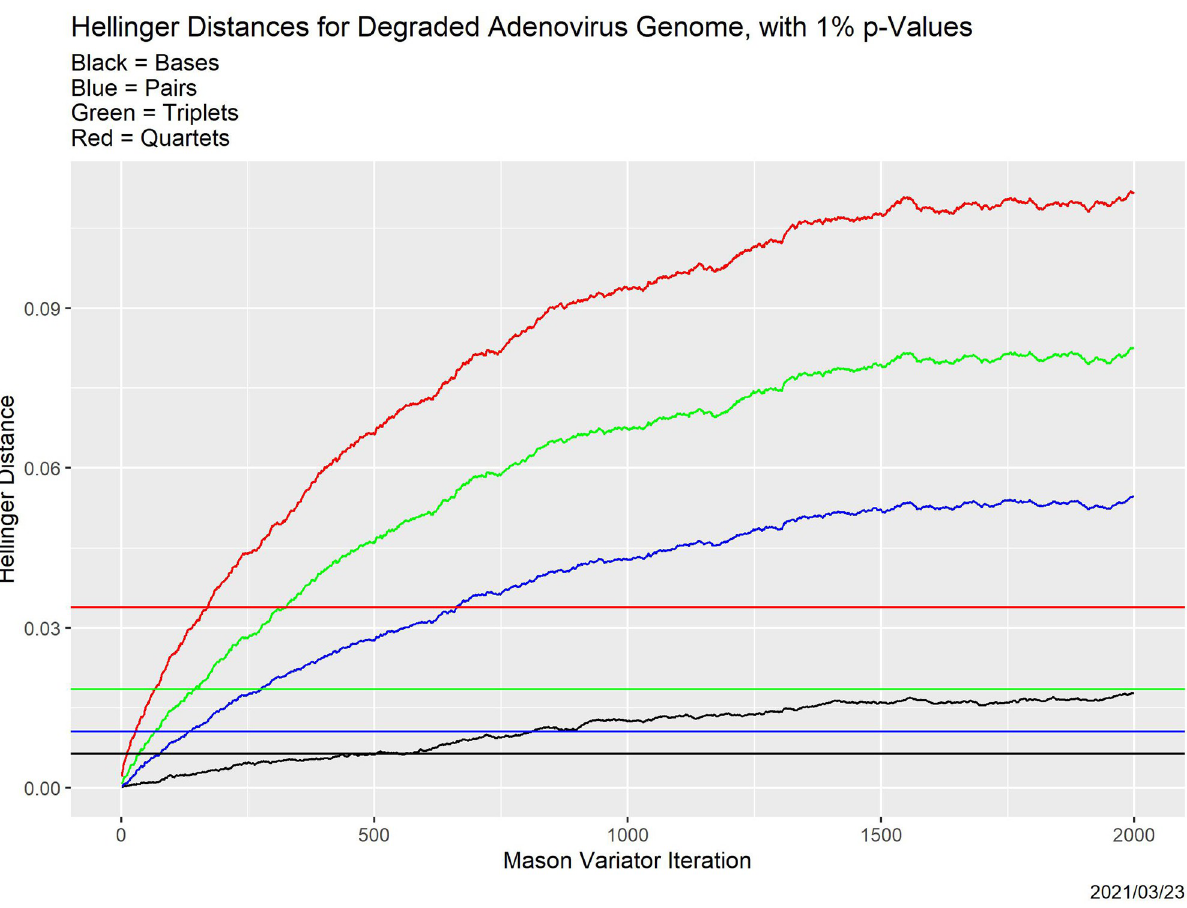
Fig 3. Effect of degradation on tuple distributions. Shown are the base distribution (black), pair distribution (blue), triplet distribution (green) and quartet distribution (red) for the adenovirus genome.